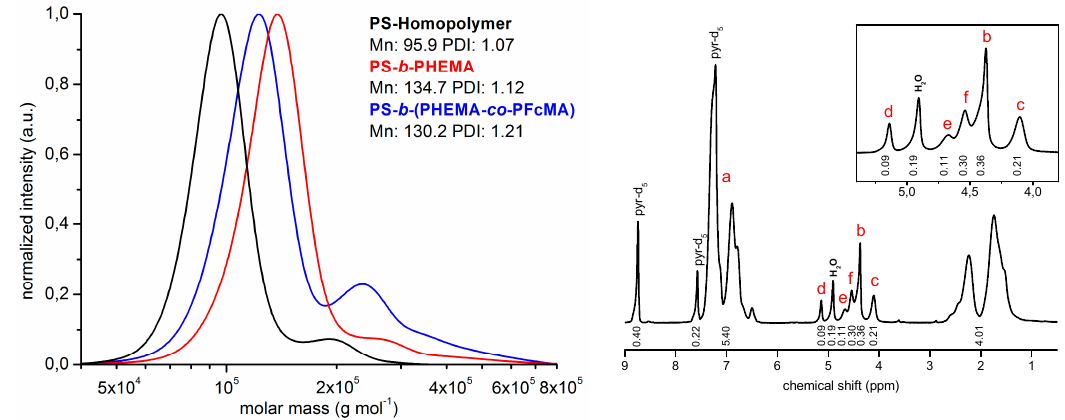
Figure 3. SEC in DMF/LiCl of the first block segment, the block copolymer PS- b -PHEMA and the ferrocene-functionalized block copolymer and 1 H NMR in pyridine- d 5 spectra of functionalized PS 60 - b - (PHEMA 13 – co –PFcMA 27 ) 123 .